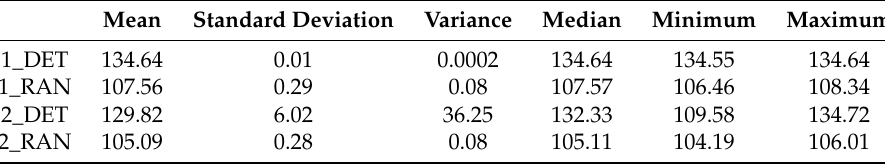
Figure 8. Box-and-whisker plots of 1000 average detector 1 s measurements for two DC/DC converters with: ( A ) deterministic modulation and ( B ) random modulation Table 2. Statistical parameters of empirical distributions of 1000 final measurements using AV